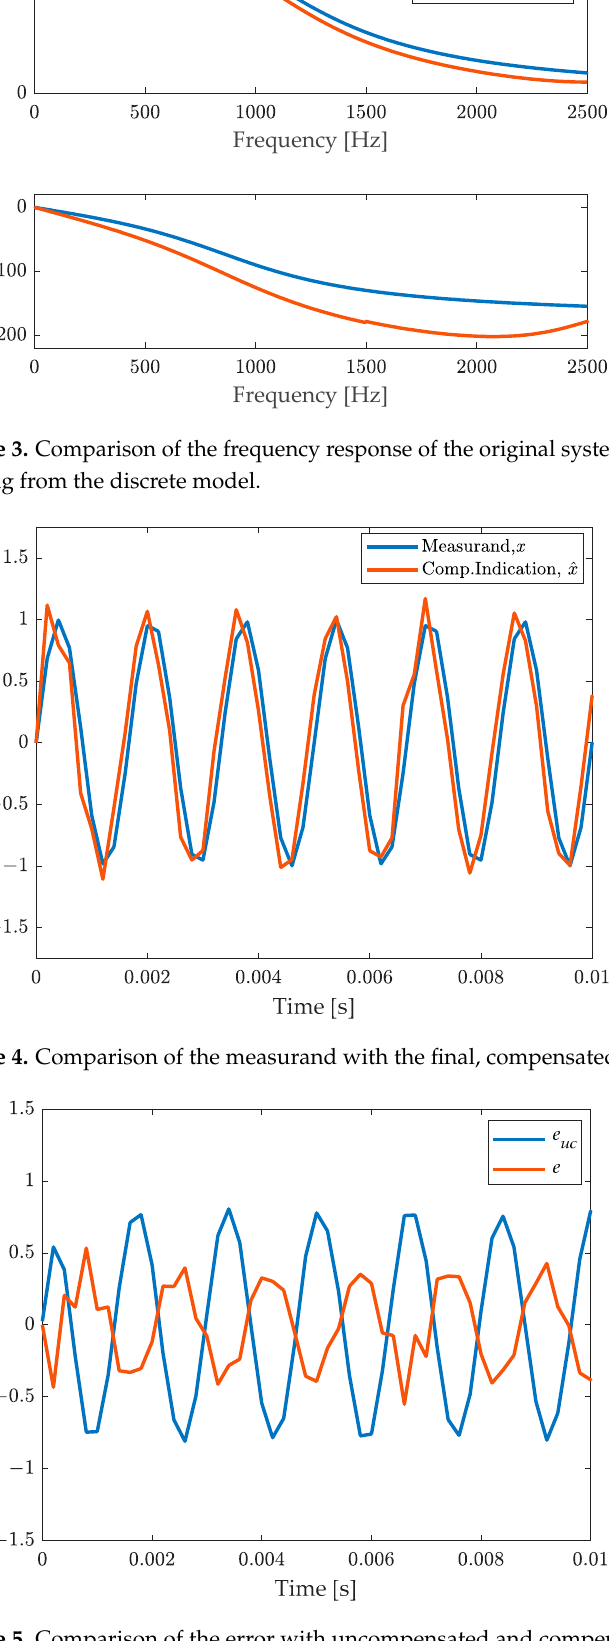
Figure 5. Comparison of the error with uncompensated and compensated result.